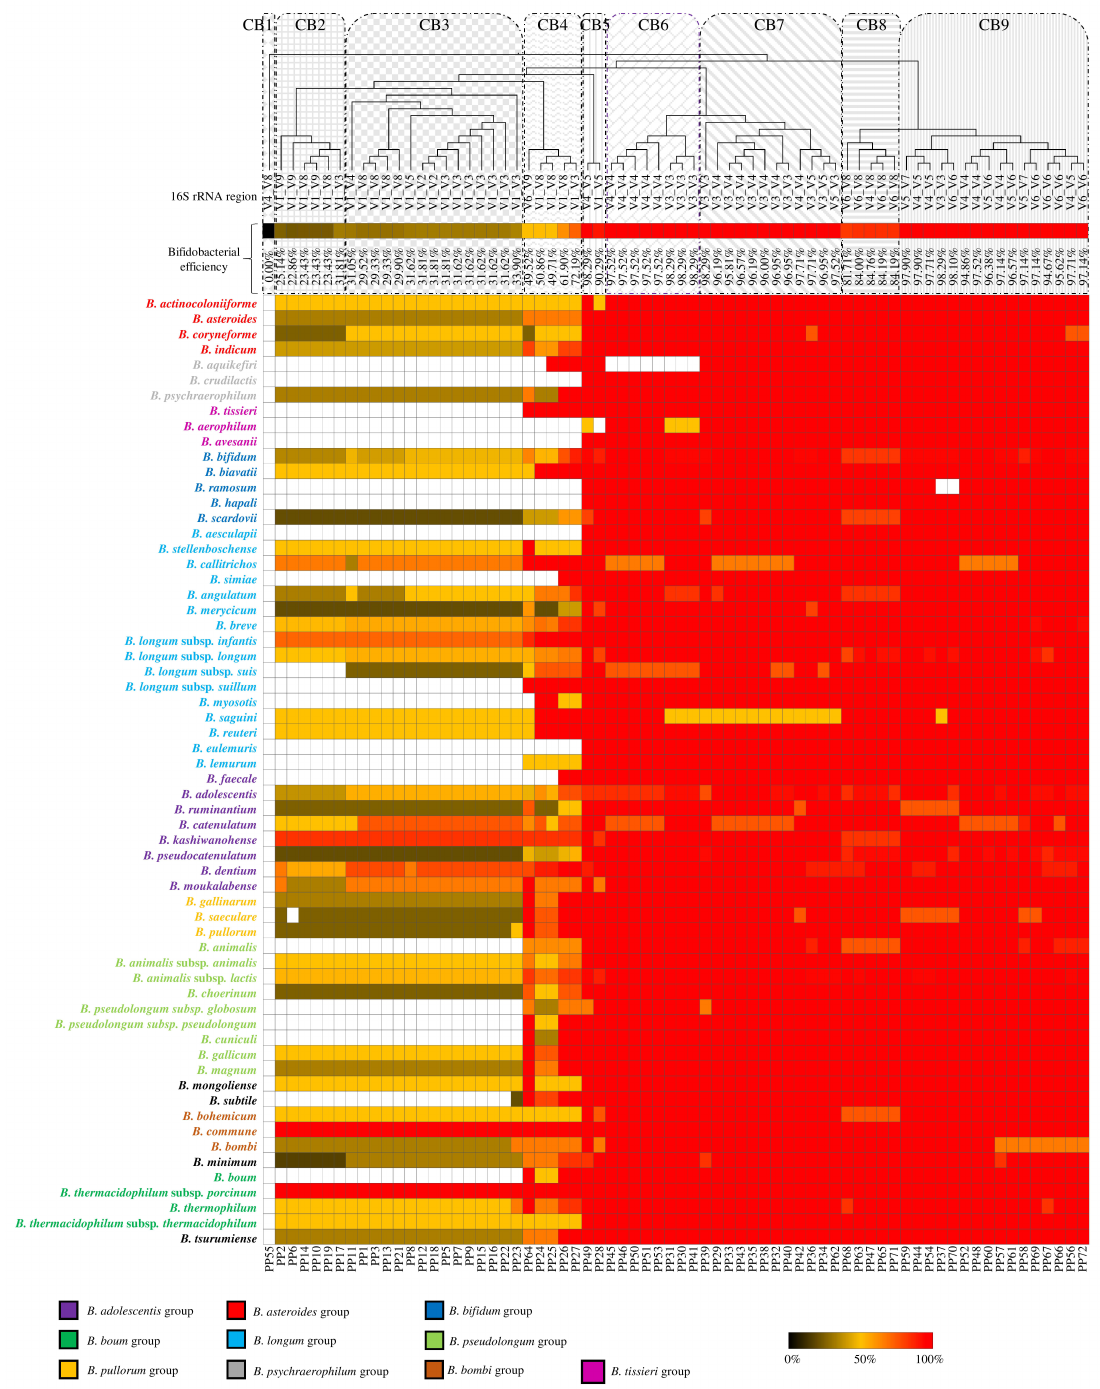
Figure 3. PCR primer pair amplification e ffi ciency towards all so far known bifidobacterial species. A heat map illustrating PCR primer pair e ffi ciency on all so far known bifidobacterial species. The bifidobacterial clusters were obtained by TM4 MeV software considering the primer pair e ffi ciency. The inability of a given PCR primer pair to amplify a particular bifidobacterial species was highlighted by a white